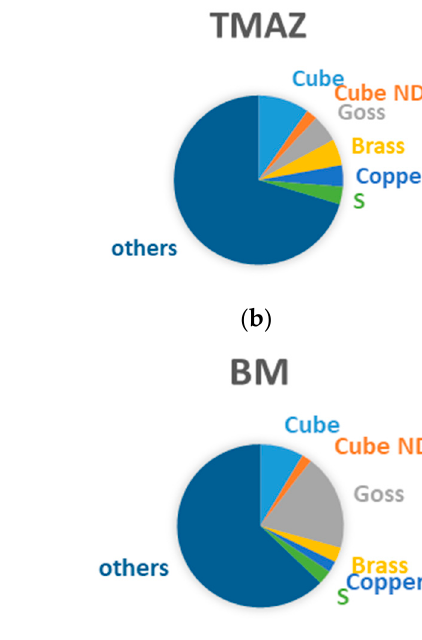
Figure 4. Crystal morphology distribution in the ( a ) WNZ, ( b ) TMAZ, ( c ) HAZ, and ( d ) BM of the joint.